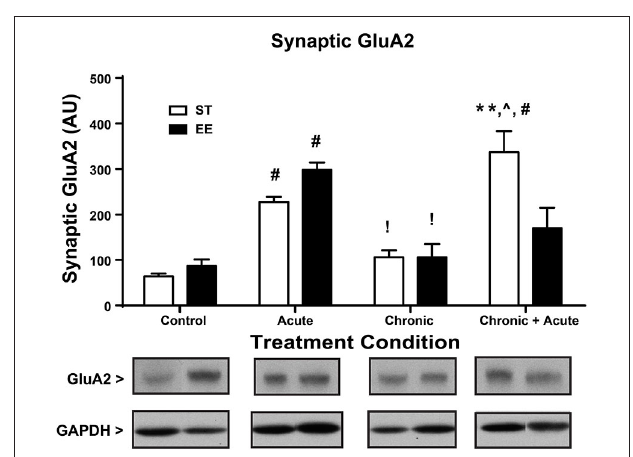
FIGURE 3 | Environmental enrichment increases GluA2 levels after chronic + acute stress. ST acute and EE acute significantly increased synaptic GluA2 compared to ST and EE controls in the same housing condition ( # p < 0.01). EE chronic and ST chronic significantly decreased synaptic GluA2 compared to the EE acute and ST acute animals of the same housing condition (! p < 0.01). ST chronic + acute significantly increased GluA2 compared to ST chronic ( ∧ p < 0.01), ST controls ( # p < 0.01) and EE chronic + acute ( ∗∗ p < 0.01).